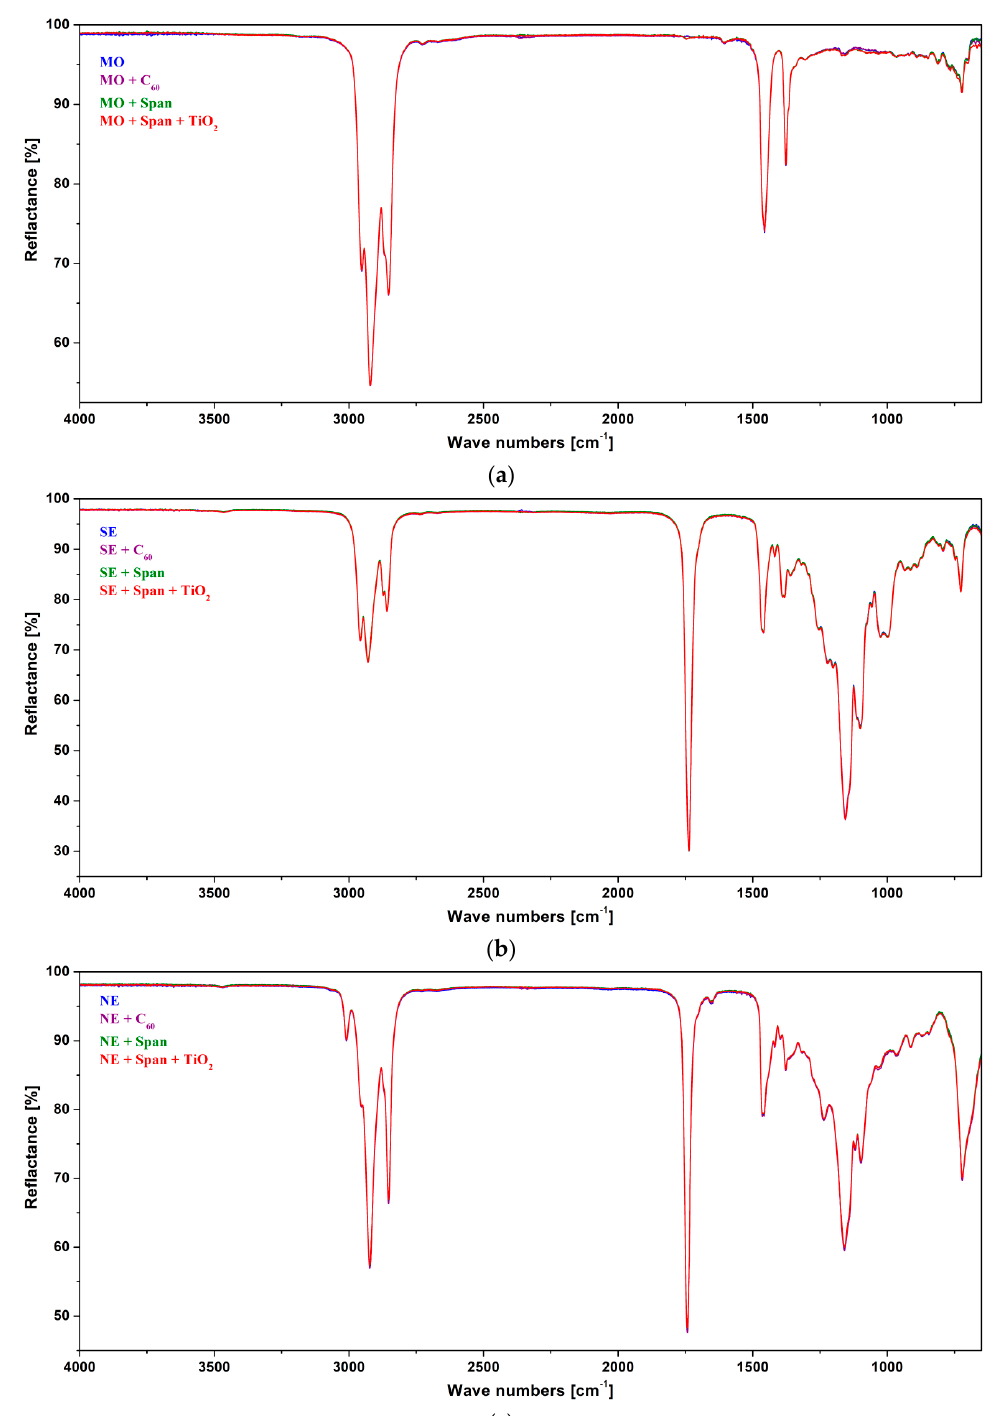
Figure 6. ATR-FTIR spectra of investigated base dielectric liquids and dielectric liquids modified with C60, TiO 2 , surfactant Span, or Span with TiO 2 at room temperature: ( a ) Mineral oil; ( b ) synthetic ester; ( c ) natural ester.